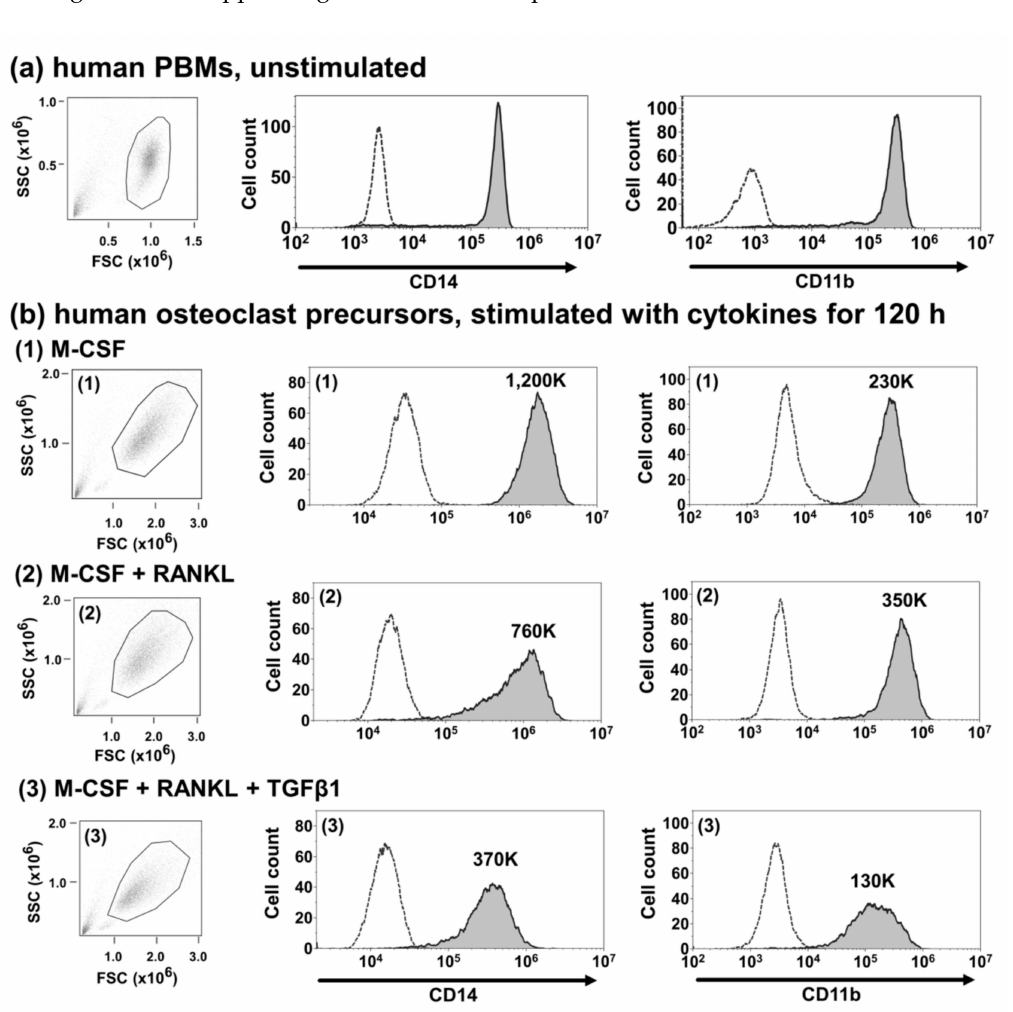
Figure 3. Inhibitory e ff ect of TGF β 1 on the cell surface expression of CD14 and CD11b of human peripheral blood monocytes (PBMs) and osteoclast precursors. ( a ) Human PBMs were freshly prepared from healthy donors. The monocyte populations were gated in a cytogram. ( b ) Human PBMs were cultured with ( 1 ) M-CSF (50 ng / mL) alone, ( 2 ) M-CSF and RANKL (100 ng / mL), or ( 3 ) M-CSF, RANKL, and TGF β 1 (100 ng / mL) for 120 h, and plastic-dish-adherent cells were harvested as osteoclast precursors, using Accutase treatment. The cell populations considered as osteoclast precursors within the same areas were gated in each cytogram. Cells were stained with fluorescein isothiocyanate (FITC)-conjugated anti-humanCD14antibodies(leftshapedhistogram)andAPC-conjugatedanti-humanCD11bantibodies (right shaped histogram). FITC- and APC-conjugated mouse IgG (left and right unshaped histogram, respectively) were similarly incubated as isotype controls. The cytogram horizontal and vertical axes show forward scatter (FSC) and side scatter (SSC), respectively. A representative result of three independent experiments from di ff erent healthy donors is shown. The numbers on each histogram indicate the net mean fluorescence intensity (MFI) calculated as the di ff erence between the MFIs of the shaped and unshaped